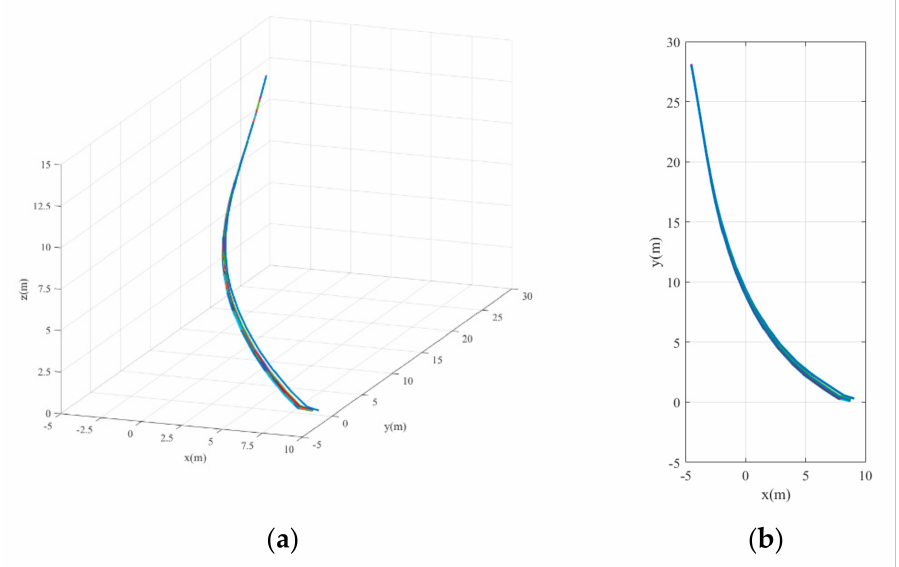
Figure 18. The landing trajectories under case 3. ( a ) 3D trajectory. ( b ) 2D trajectory in the x - y plane.